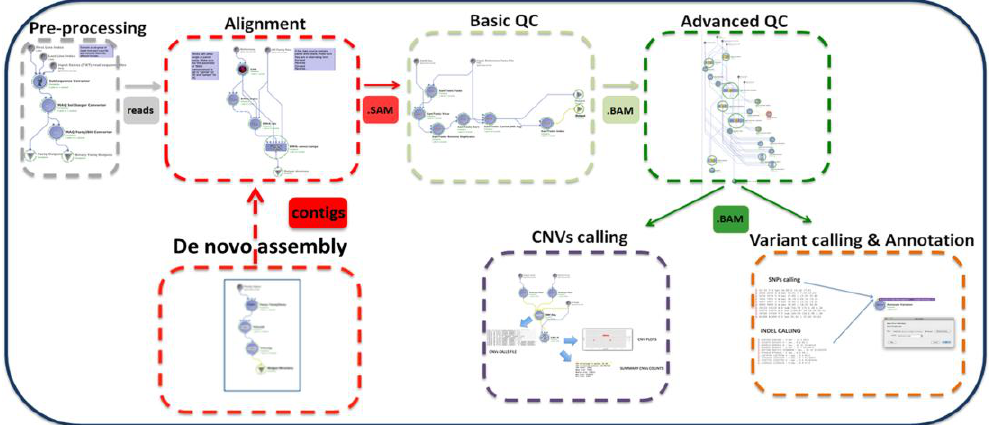
Figure 2. An example of the workflow approach to analyze DNA-Seq data in GPCG. Several alternative workflows can be run independently or connected in a logical flow. Once the reads have been pre-processed, they can be aligned (1.1), undergo (1.3) Basic and (1.4) Advanced QC, (2.1a) SNP/Indels and (2.1b) CNVs calling and annotation. The reads can also undergo (1.2) de novo assembly, and if a reference genome is available the contigs can be realigned back to the reference genome and then undergo the following computational